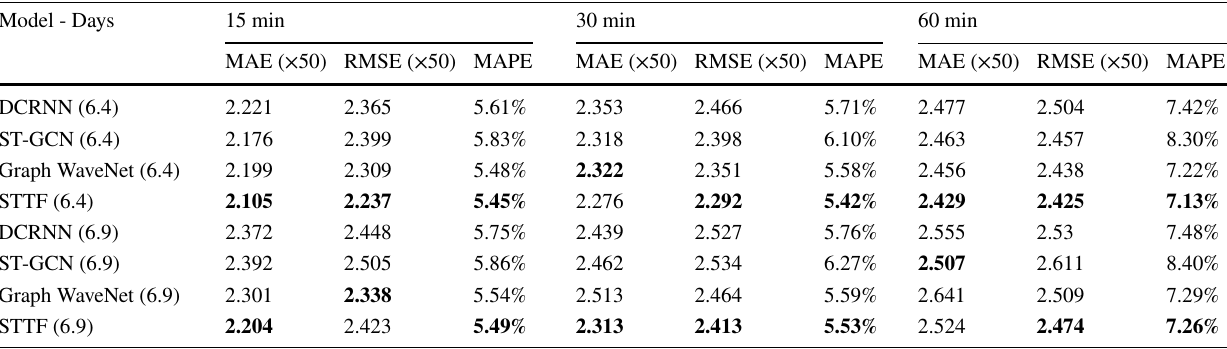
Table 4 Performance of each model in weekdays and weekends with different time intervals and same prediction time steps (predictions are made every 30 minutes and the optimal values in the same day are bolded)